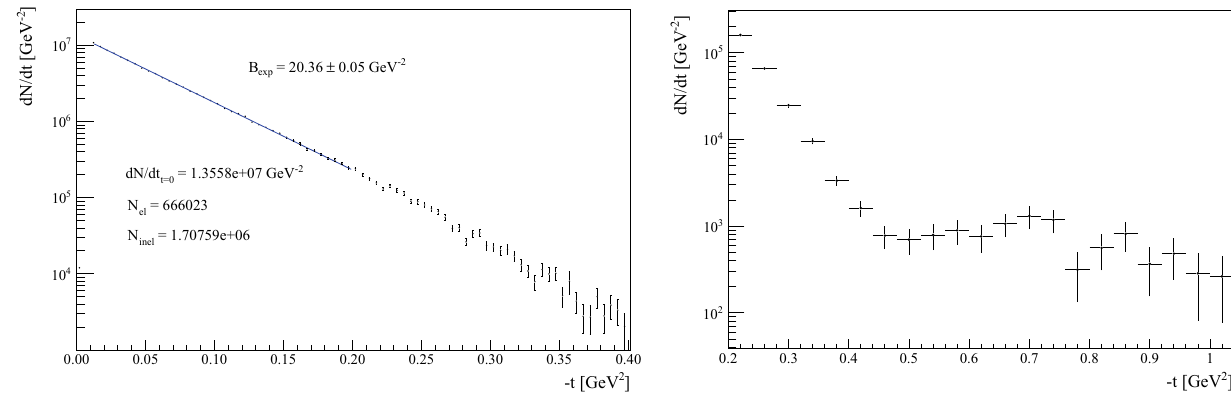
√ Fig. 3 Differential elastic rate d N el / d t at s = 13 TeV (full physics corrections included) of dataset DS2 with the exponential fit between | t | min and | t | max . The right panel shows the data in the dip region. The uncertainties shown and quoted are only